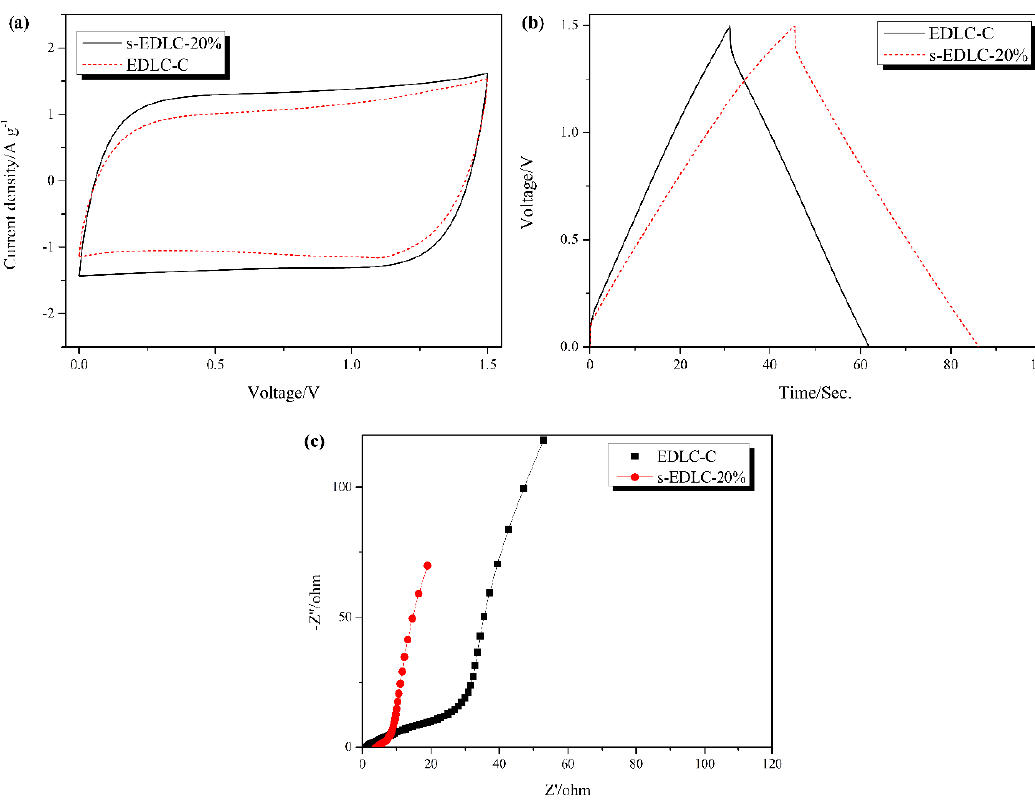
Figure 9. Comparison of CV curves ( a ), GCD profiles ( b ) and Nyquist plots ( c ) between s-EDLC-20% with the polymer electrolyte GPE-20% and EDLC-C with a commercial separator .